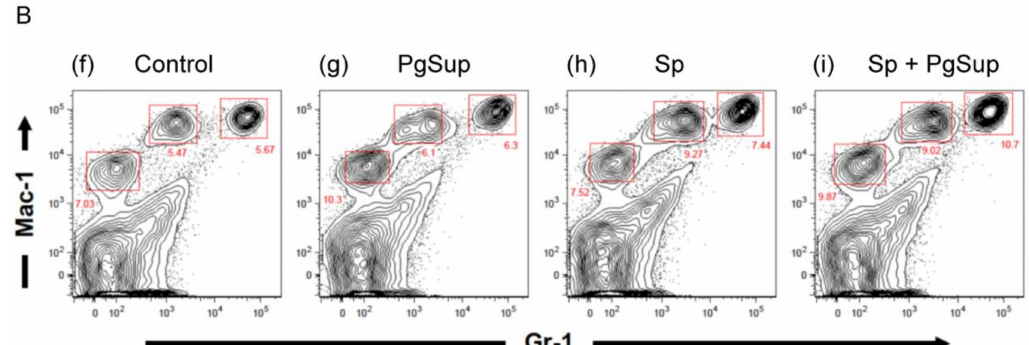
Figure 2. Histopathological analysis and cellular composition during the inflammatory cell infiltration of Sp-infected mice with and without PgSup. ( A ) The mice were euthanized 24 h after inoculation and lung collection was performed. ( a – d ) HE- stained histological section images are shown: ( a ) sTSB administration, ( b ) PgSup administration, ( c ) Sp administration, ( d ) Sp and PgSup mixed administration. The boxed regions are magnified in the lower images. Original magnification: × 10 (upper images), × 40 (lower images). ( e ) The percentage of interstitium in areas of the HE-stained histological sections. “+” indicates the presence of PgSup or Sp, and “ − ” indicates the absence of PgSup or Sp. Each group was analyzed by one-way ANOVA, and data are presented as the mean ± SD. Significant differences were analyzed using the Kruskal–Wallis test (* p < 0.05, ** p < 0.01). ( B ) Mice were sacrificed 24h after administration with ( f ) sTSB, ( g ) PgSup, ( h ) Sp, or ( i ) Sp-PgSup mixed. The cells were prepared from the lung and stained with Mac-1 and Gr-1 mAbs for flow cytometric analysis. The dots surrounded by a square represent neutrophils and monocytes/macrophages. Representative results from three separate experiments are shown in each panel.